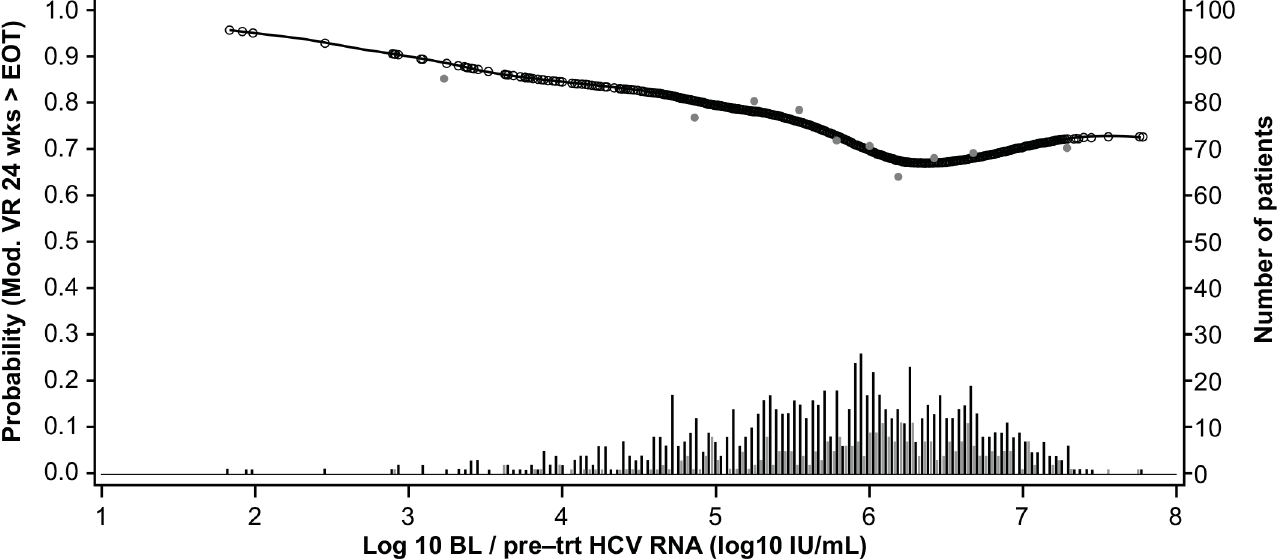
Fig 7. Relationship between serum hepatitis C virus RNA level and sustained virologic response (SVR). Short vertical lines indicate the number of patients with SVR (black lines) and no SVR (grey lines). Open circles represent probability of SVR according to the GAM analysis. Closed circles represent empirical probability for midpoints of